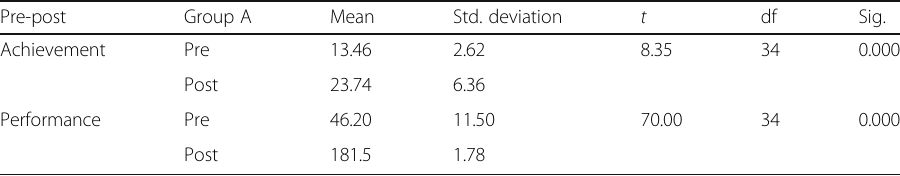
Table 2 Results of descriptive statistics and paired samples t test for group A ( n = 35) Pre-post Group A Mean Std. deviation t df Sig. Achievement Pre 13.46 2.62 8.35 34 0.000 Post 23.74 6.36 Performance Pre 46.20 11.50 70.00 34 0.000 Post 181.5 1.78 p <